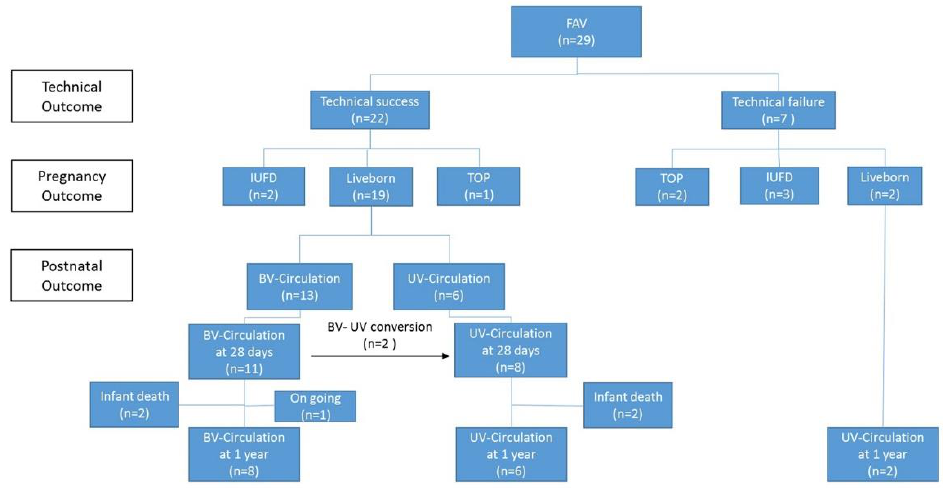
Figure 6. Flowchart summarizing the outcome of 29 fetuses following fetal aortic valvuloplasty. The maternal age at intervention was 31.62 ( ± 5.05) with a body mass index (BMI) of 27.38 kg/m 2 ( ± 6.68). Gestational age at first intervention was 26.14 weeks ( ± 2.56); 23/29 (79.31%) fetuses were male.